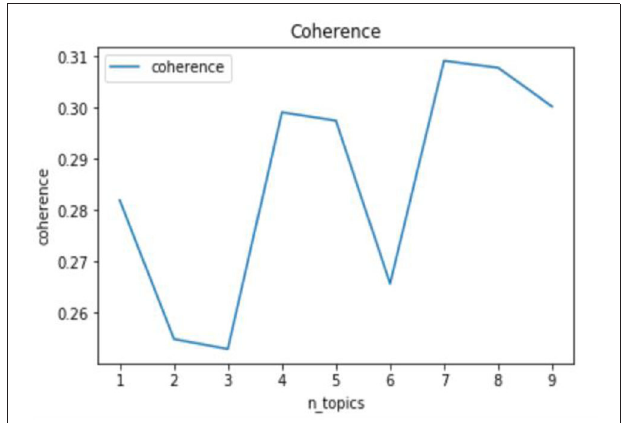
FIGURE 5 | Calculation of coherence.